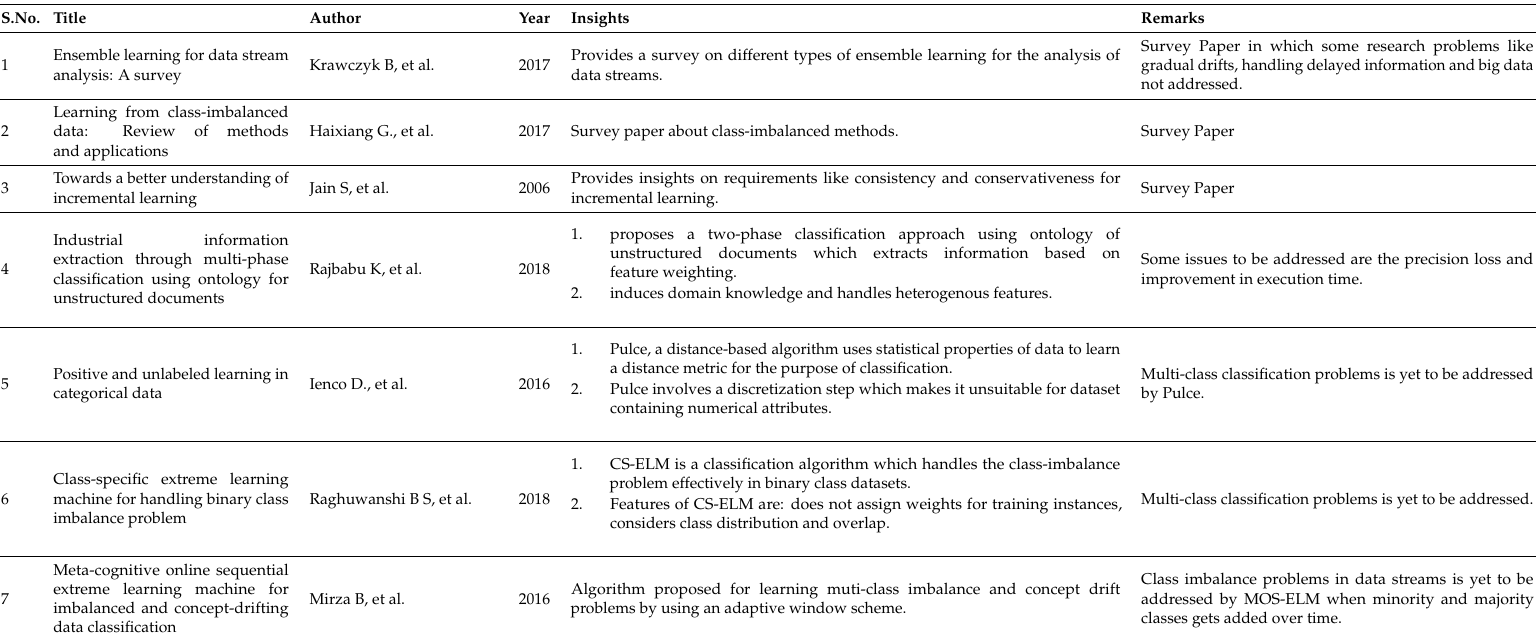
Table 1. Summary of the related works.